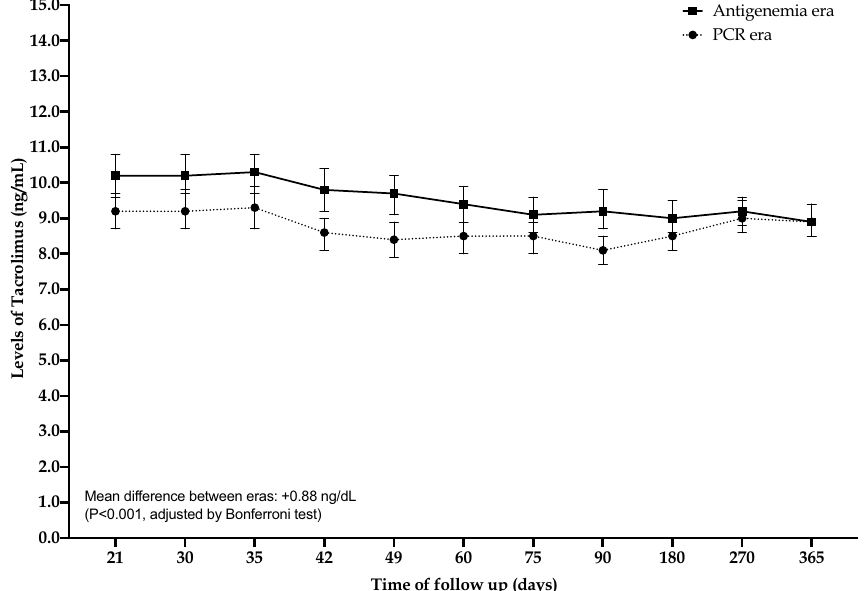
Figure 2. Levels of tacrolimus according to groups (eras) in the first year of transplantation. The mean of eGFR between eras (antigenemia and RT-PCR) was compared by generalized estimating equation modeling and adjusted by Bonferroni test. Squares and circles in the plot represent mean and bars the 95% confidence interval. PCR, real-time polymerase chain reaction.